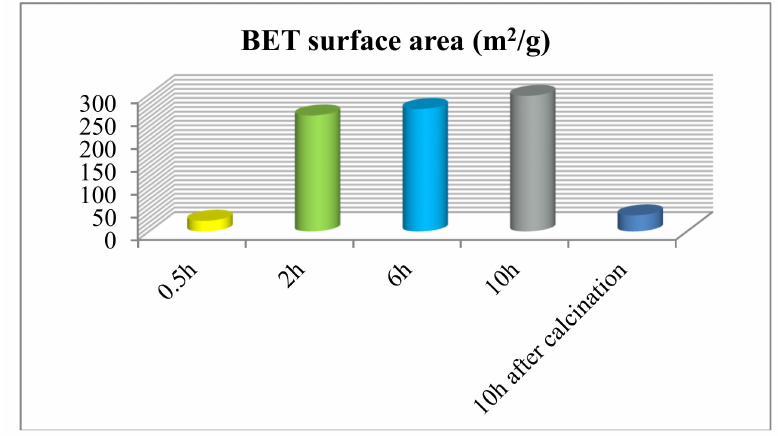
Figure 4. The surface area of the different TiO 2 products: 0.5 h; 2 h; 6 h; 10 h; 10 h after